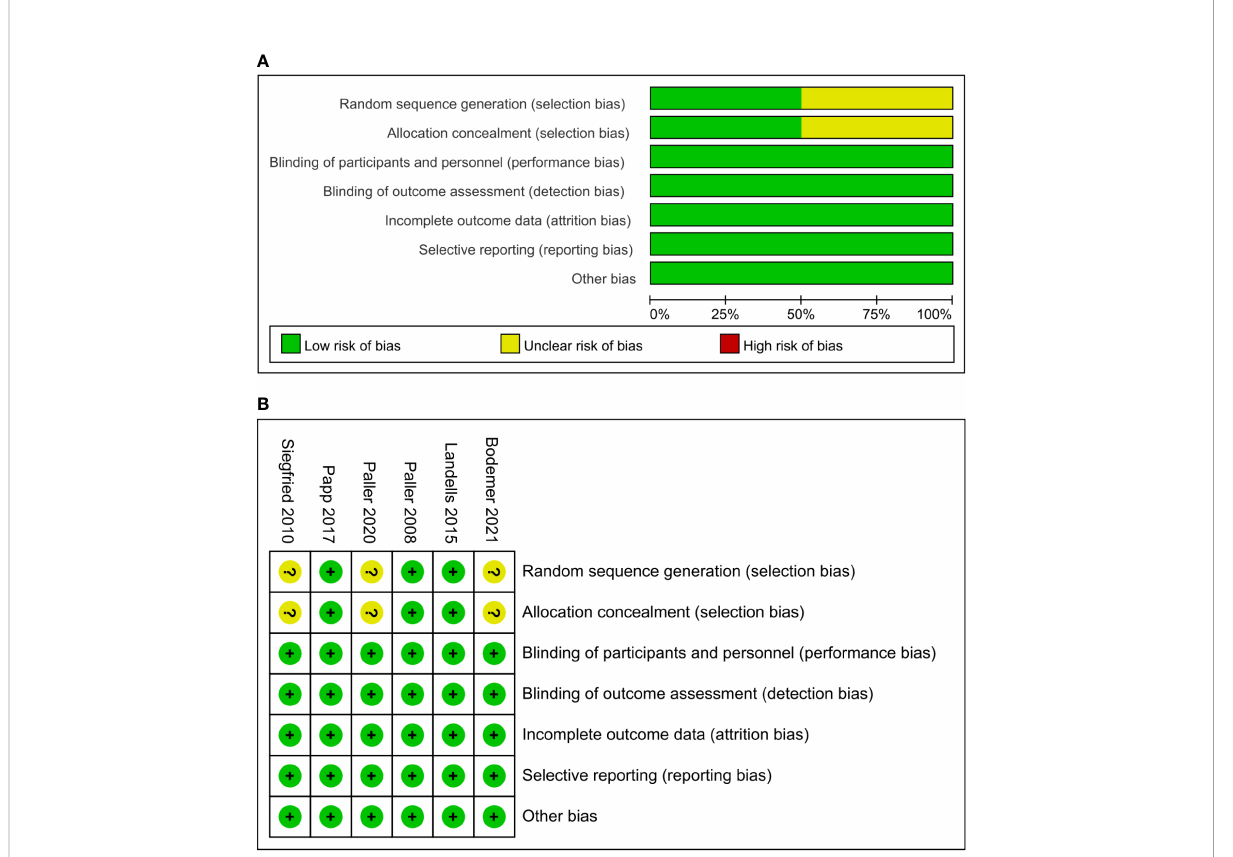
FIGURE 2 Risk of bias summary of clinical studies (A) . Risk of bias graph of clinical studies (B)